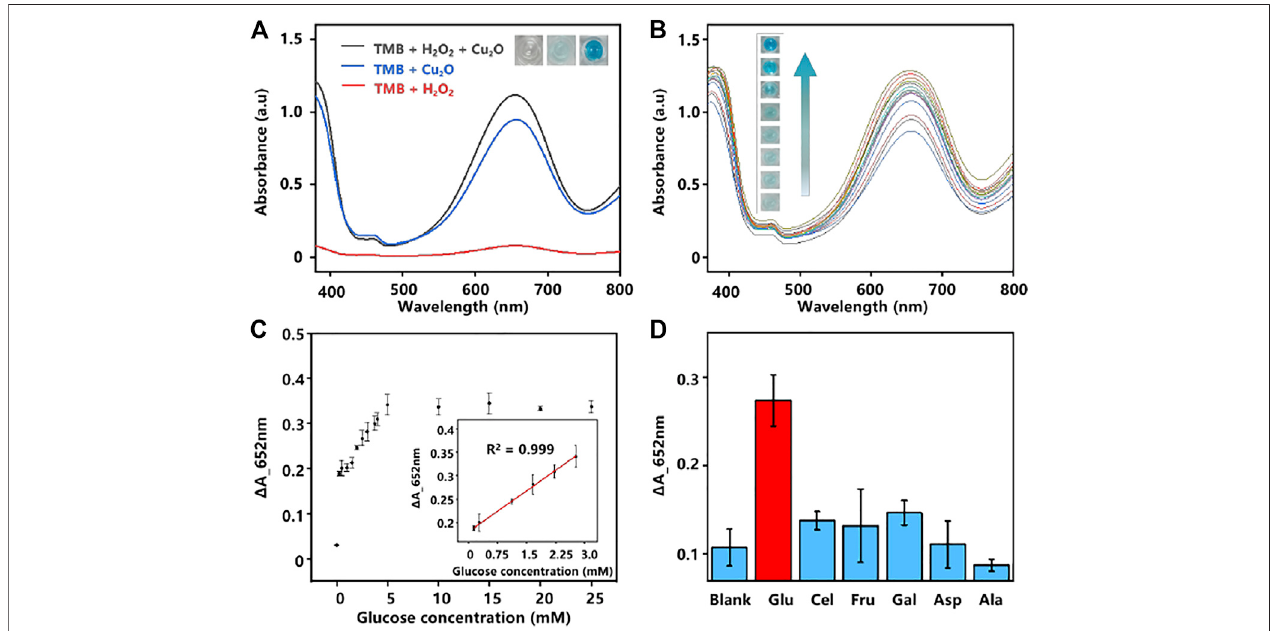
FIGURE2|(A) UV-Visabsorptionspectraofdifferentsystems.Insetimages:colorchangesofthecorrespondingsystem. (B) UV-Visabsorptionspectraofvarious concentrations of glucose were analyzed based on the GOD-Cu 2 O NPs-TMB system (0 – 10 mM, the interval of 1.25 mM from bottom to top). (C) The relationship plot and the linear curve (inset) between the concentration of glucose and the absorbance intensity at 652 nm. The error bars denote the SD of three measurements. (D) Selectivity analysis of the assay by monitoring the absorbance change of glucose and its analogs. The error bars denote the SD of fi ve measurements.